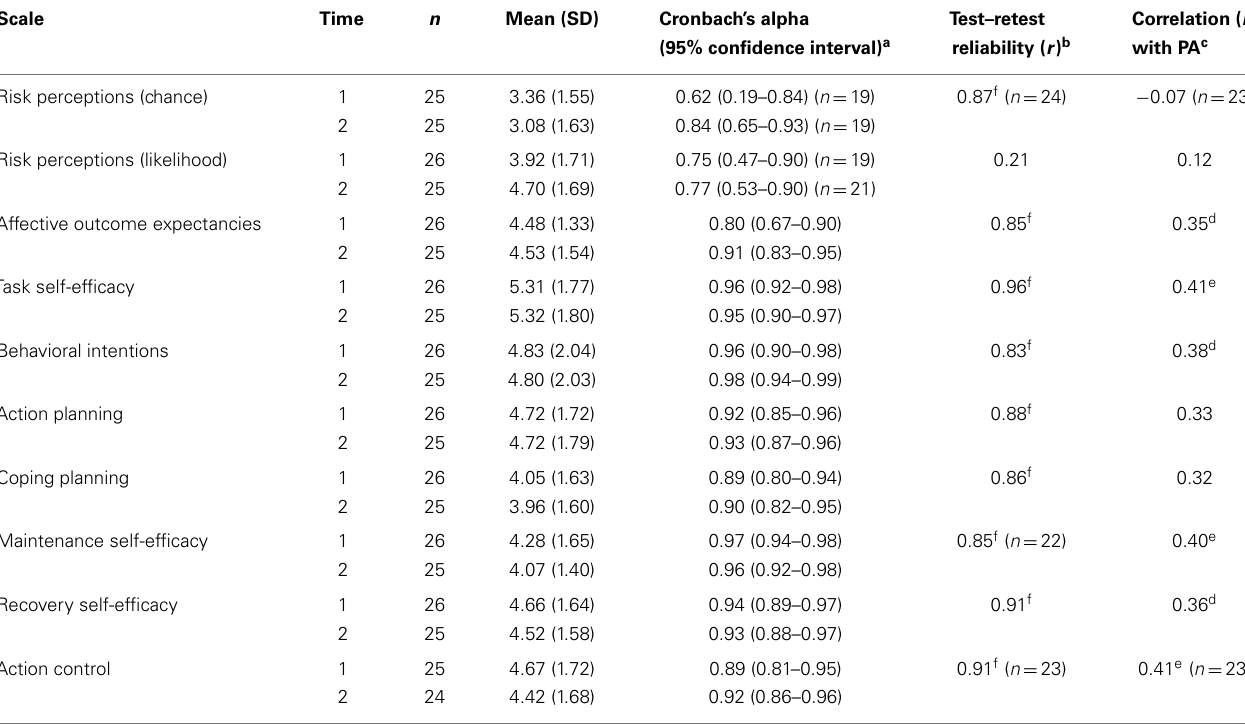
Table 2 | Summary of HAPA inventory psychometric properties and correlation with minutes of at least moderate physical activity